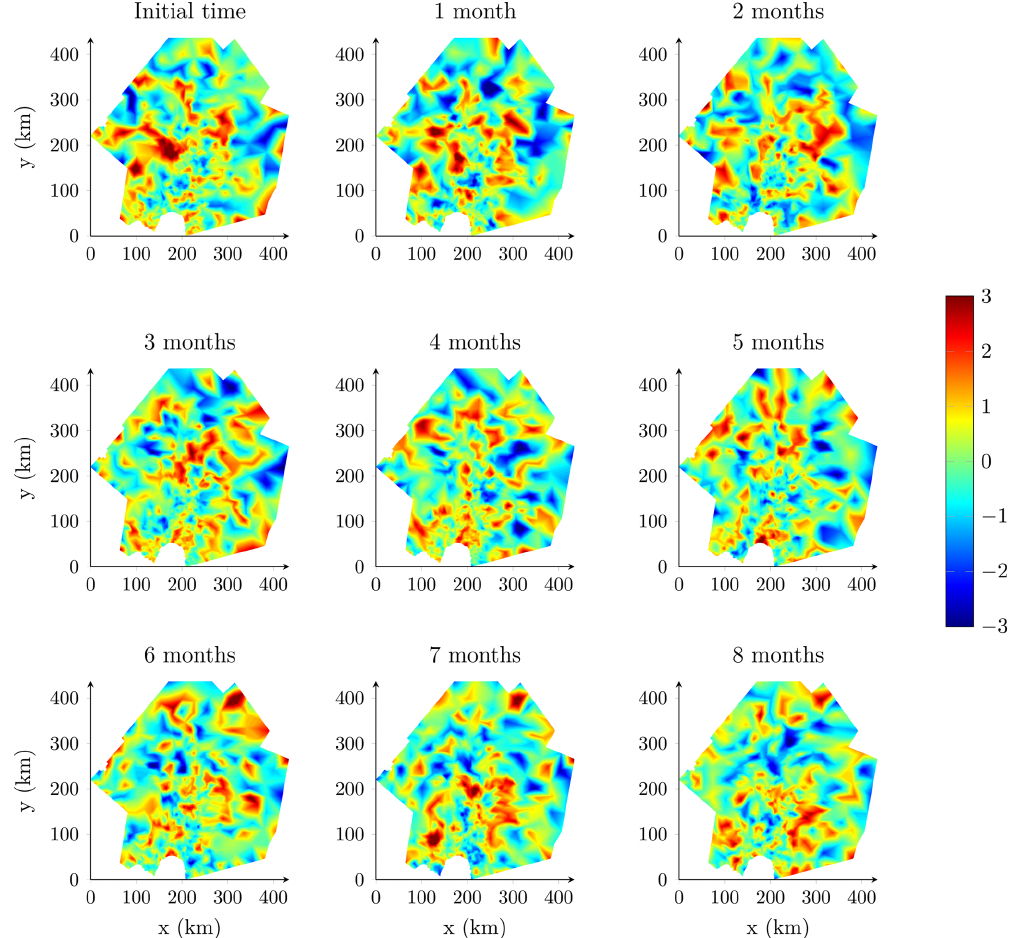
Figure 14. Transient samples of random perturbation over Pine Island Glacier with a temporal correlation of 0.5.